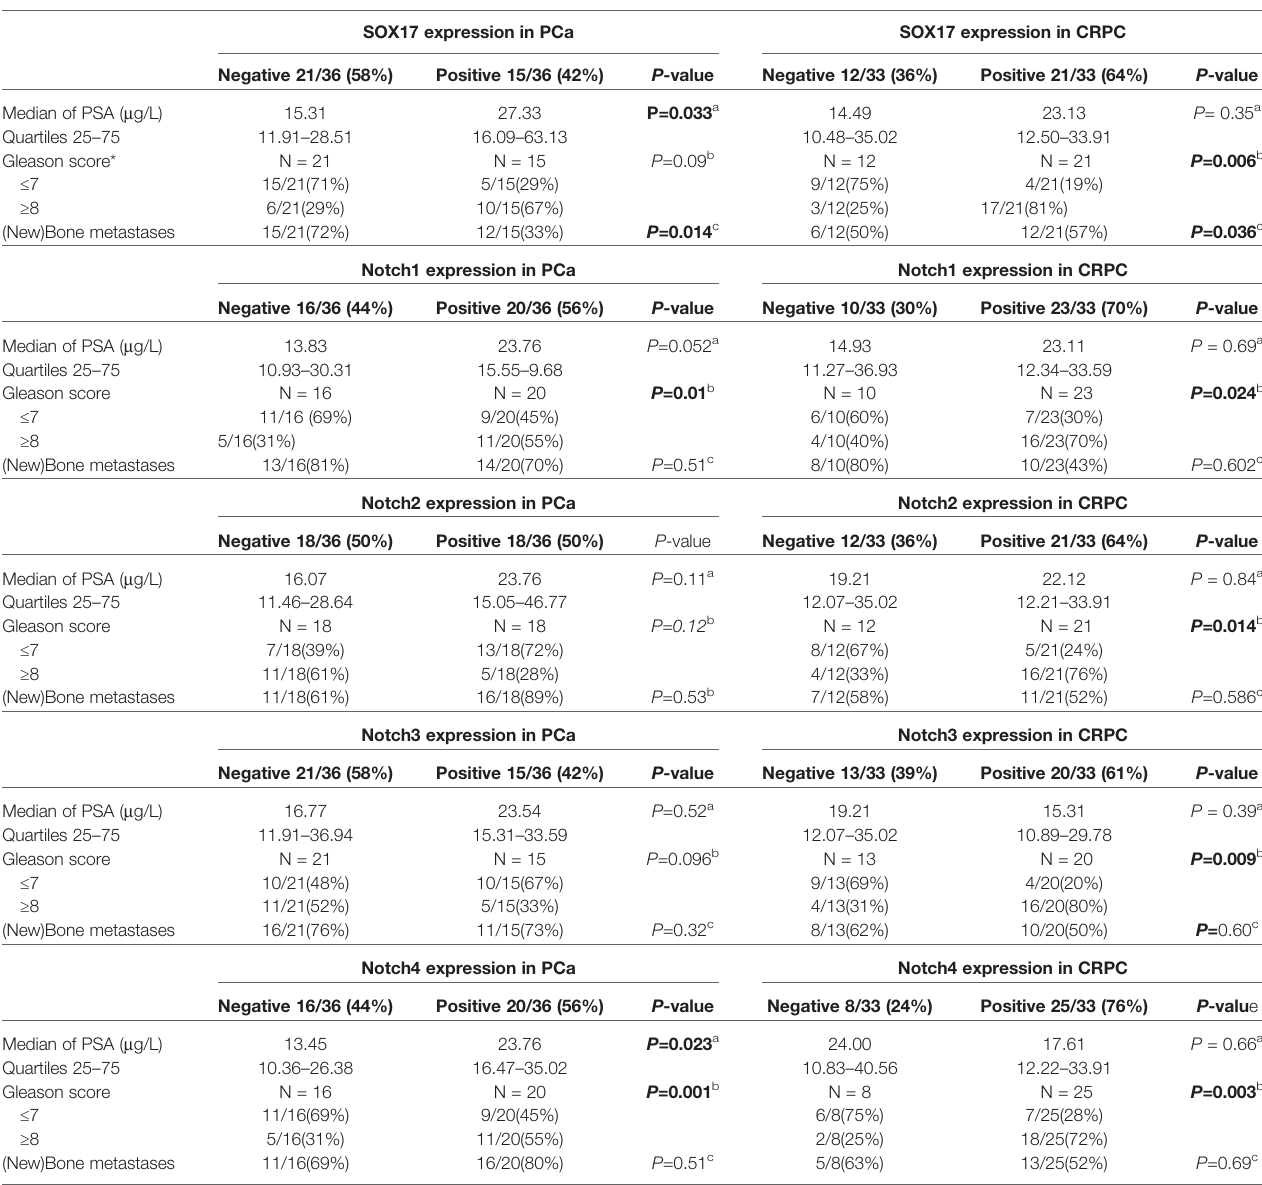
TABLE 1 | Demographic and clinical characteristics of the patients with PCa or